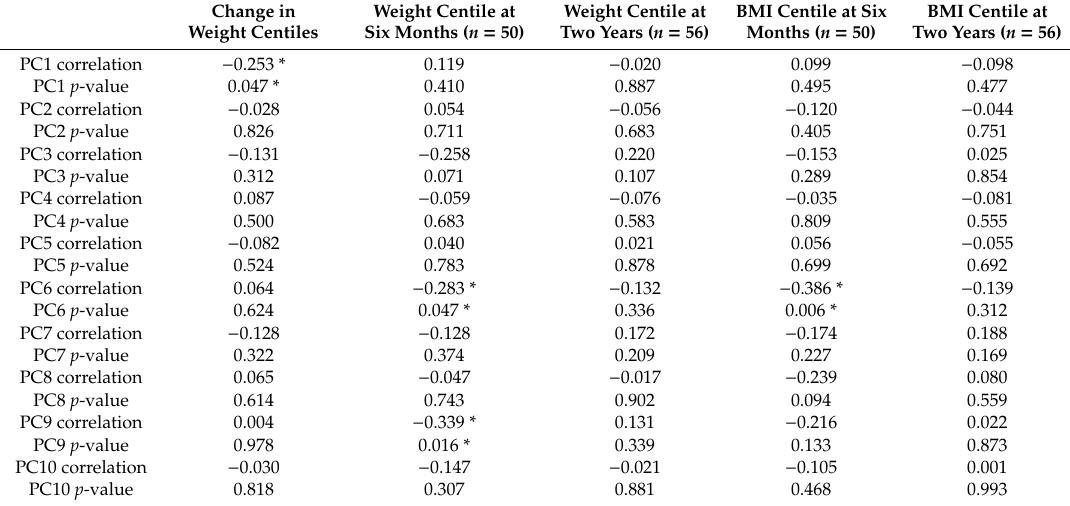
Table 6. Principal component analysis of early childhood weight and growth influencing DNA methylation levels at five years of age. Change in Weight Centile at Weight Centile at BMI Centile at Six BMI Centile at Weight Centiles Six Months ( n = 50) Two Years ( n = 56) Months ( n = 50) Two Years ( n =